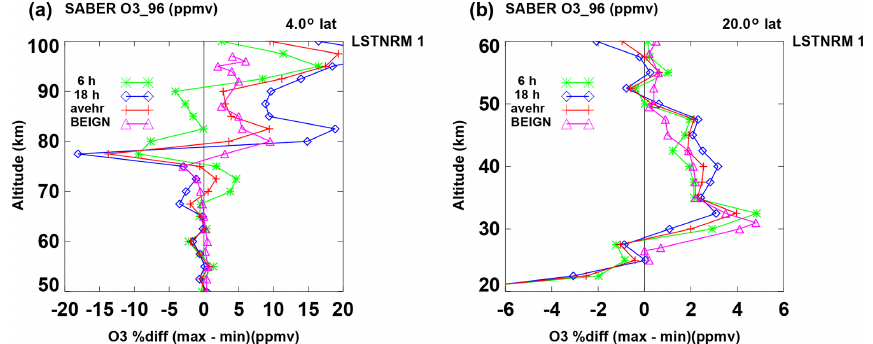
Figure 3. Ozone responses to the solar decadal cycle versus altitude at 4 ◦ N from 50 to 100km (a) , and at 20 ◦ N from 20 to 60km (b) . Values are responses at solar max minus responses at solar min (%/100sfu). Magenta triangles denote the results from Beig et al. (2012), which are the average of responses at 6 and 18LST (local time) and 0–30 ◦ N; red plusses denote our estimate (average at 6 and 18LST); green asterisks denote our estimate at 6LST; and blue diamonds denote our estimate at 18LST.